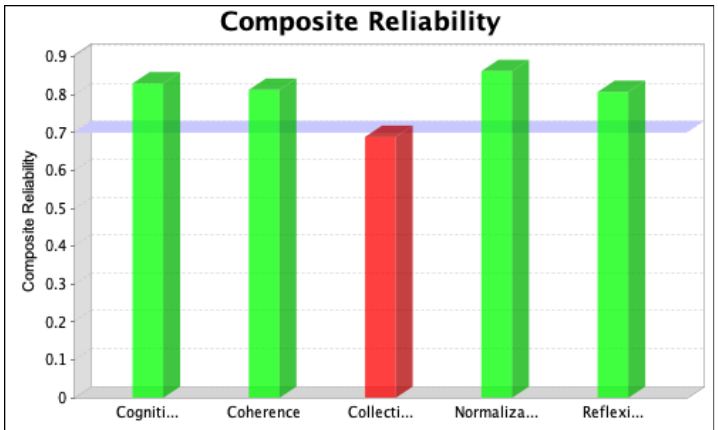
Figure 6. Values of composite reliability in the second iteration.